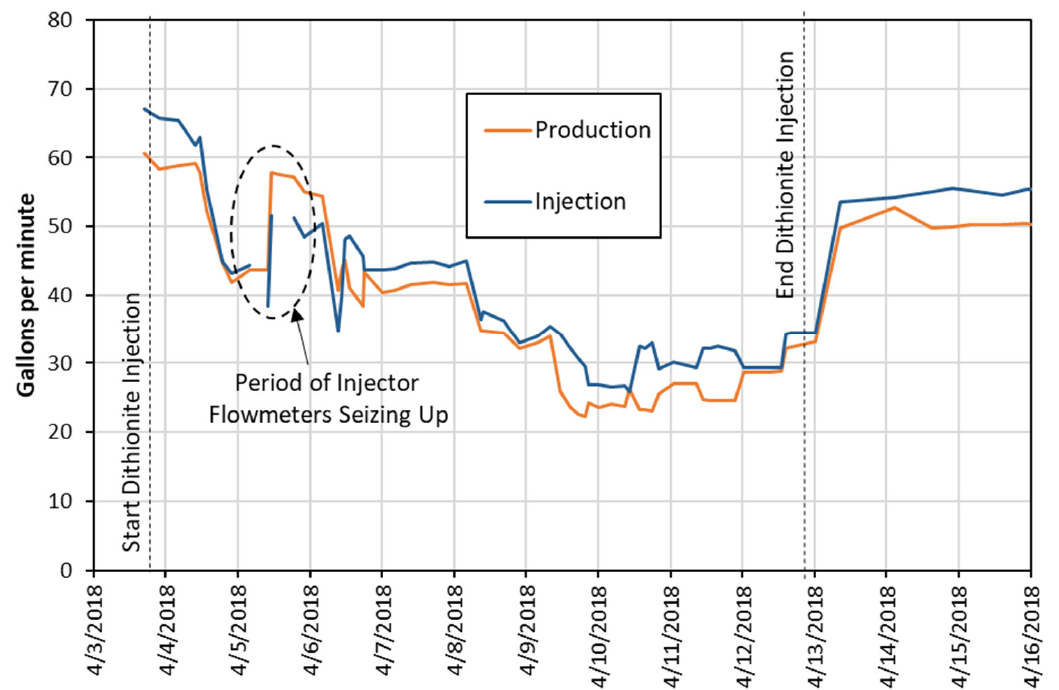
Figure A13. Combined production and injection flows in the six well patterns during and immediately after the dithionite injection. Black precipitate caused injection well flowmeters to seize up and malfunction on 5 April 2018.